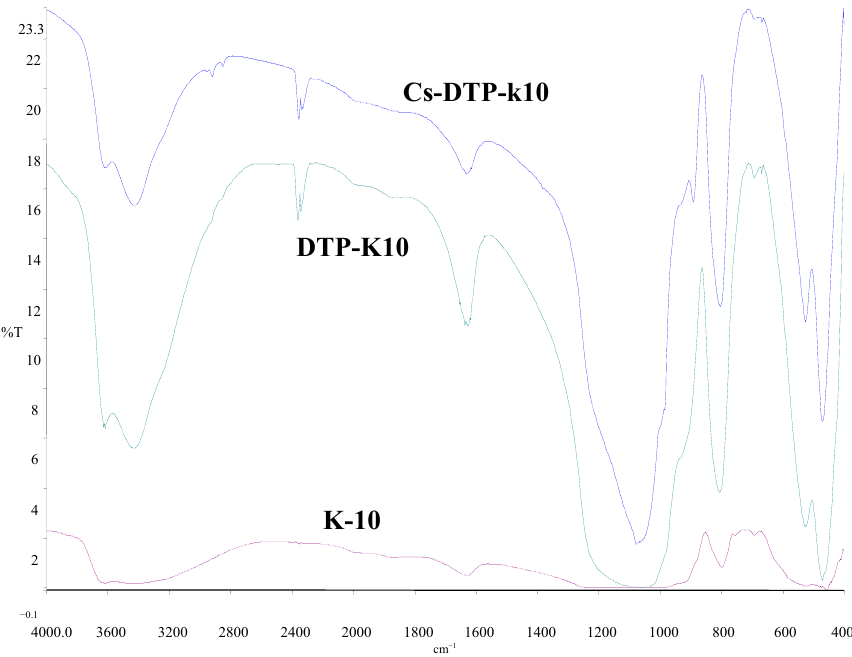
Figure 2. FT-IR patterns of unsupported K-10, bulk DTP on K-10 and 20% w / w Cs-DTP/K-10.